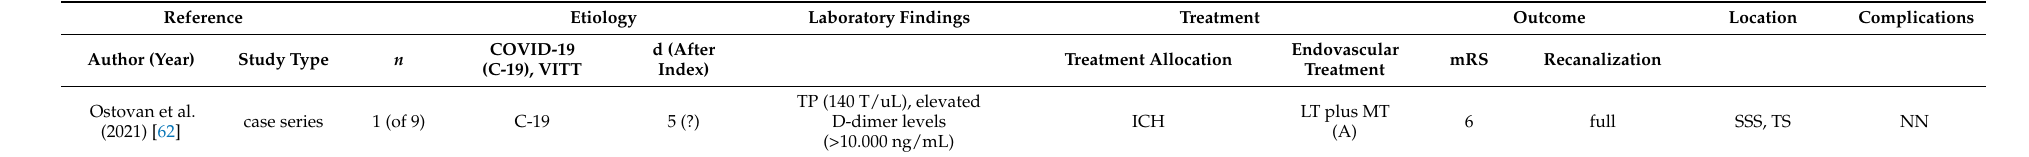
Table 2. Case reports of endovascular therapy in SVT due to COVID-19 or